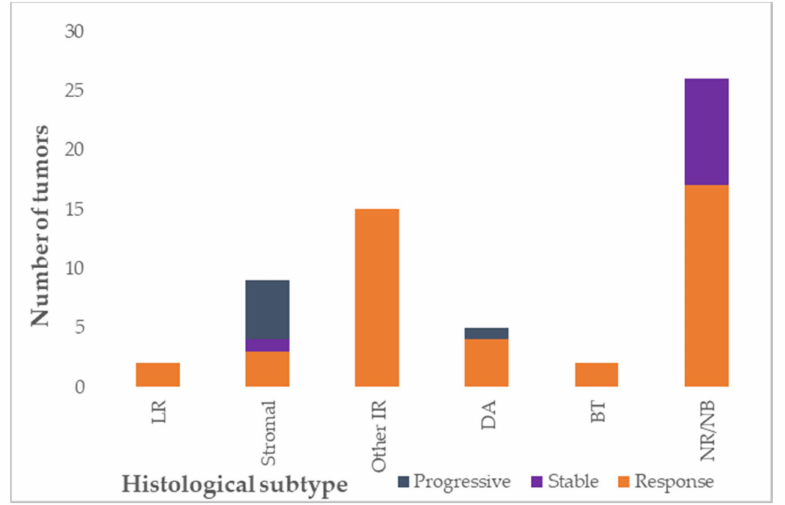
Figure 2. Response to preoperative chemotherapy according to histological subtype, depicted per lesion (total evaluable n = 58, Wilms tumor = 33, nephrogenic rests n = 25). LR: low-risk; IR: intermediate-risk; DA: diffuse anaplasia; high-risk blastemal type; NR: nephrogenic rest; NB: nephroblastomatosis. Response: >10% volume reduction of tumor, stable: less than 10% increase or decrease in tumor volume, progressive: >10% increase in tumor